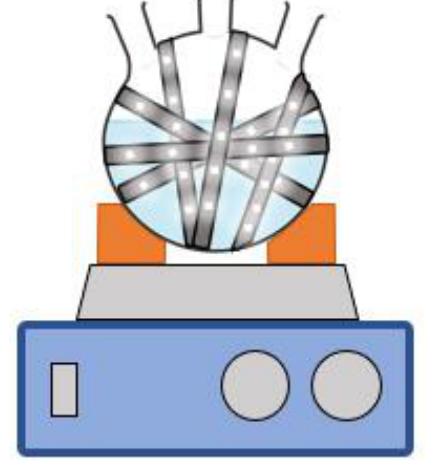
Figure 8 . Reactor used in the experiments with LED light. Figure 8. Reactor used in the experiments with LED